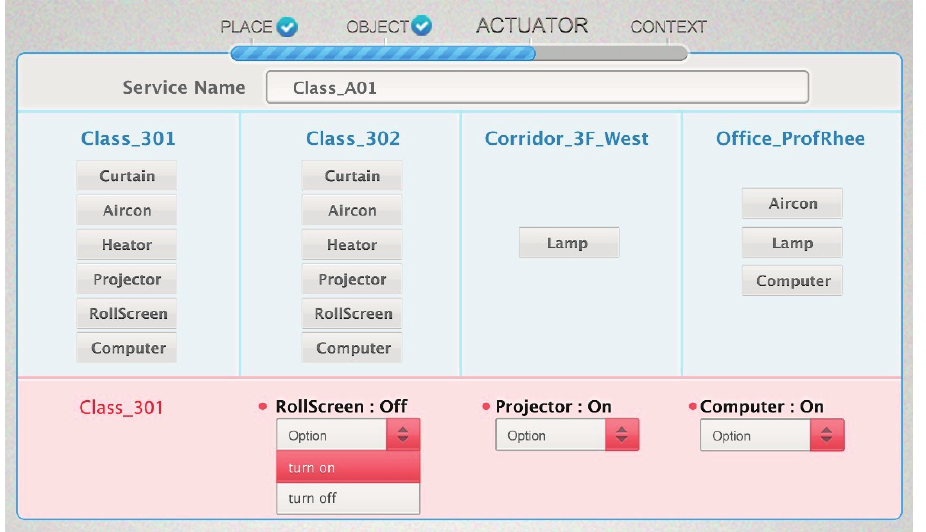
Figure 19. Web-based service modeling UI (Phase 3: object and function